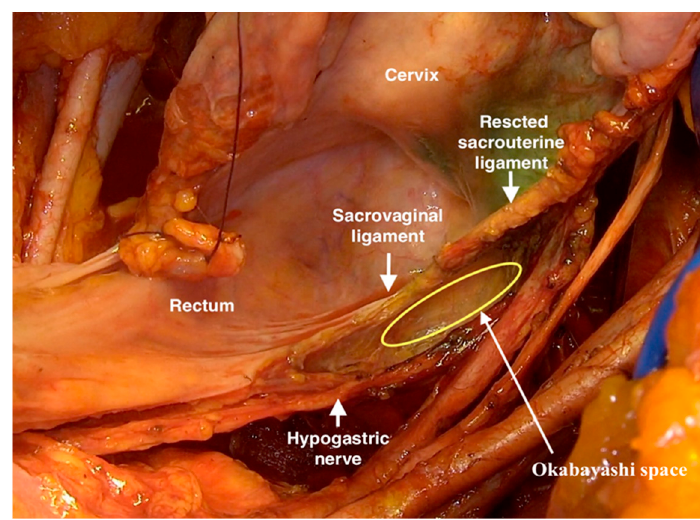
Figure 3. Resection of the dorsal parametrium (sacrouterine ligament) and the dorsal paracolpium (sacrovaginal ligament) to the tendinous arch of the pelvic fascia with sparing the hypogastric nerves and the dorsal part of inferior hypogastric plexus.